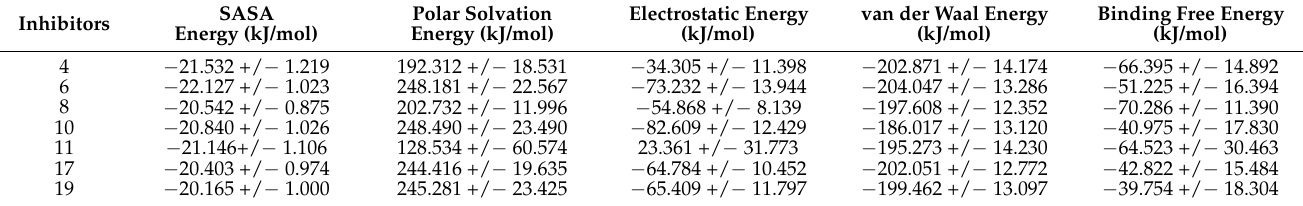
Table 3. Binding energies of 1,7-dihydro-dipyrrolo [2,3-b:3 (cid:48) ,2 (cid:48) -e] pyridine-like inhibitors with JAKs and contributions to